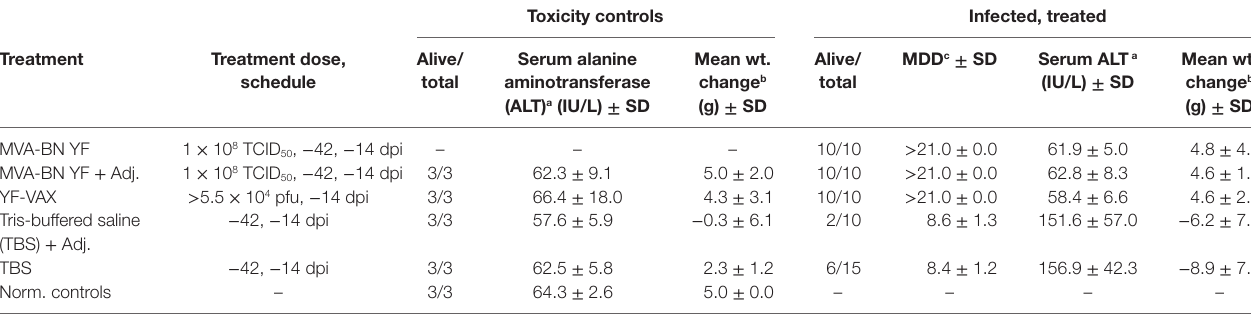
TaBle 1 | Efficacy of vaccination with MVA-BN YF on disease in hamsters challenged with YF virus. Toxicity controls infected, treated Treatment Treatment dose, schedule